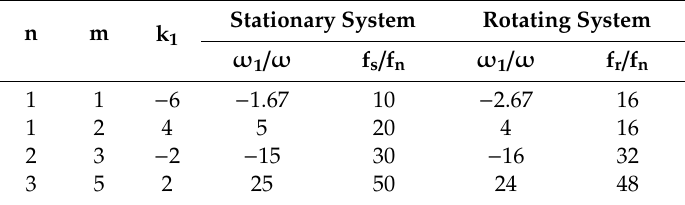
Table 3. Frequency of rotor–stator interaction under di ff erent pitch moduli. Stationary